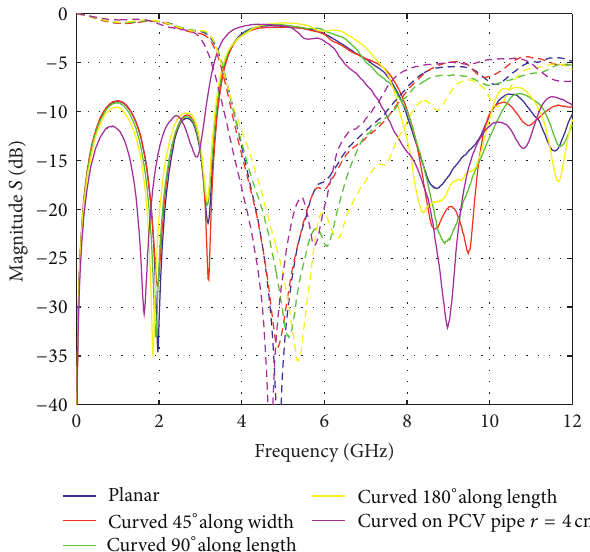
Figure 15: Measured magnitude of the scattering parameters for the filter in its planar and curved version. 𝑆 11 : solid line. 𝑆 21 : dashed